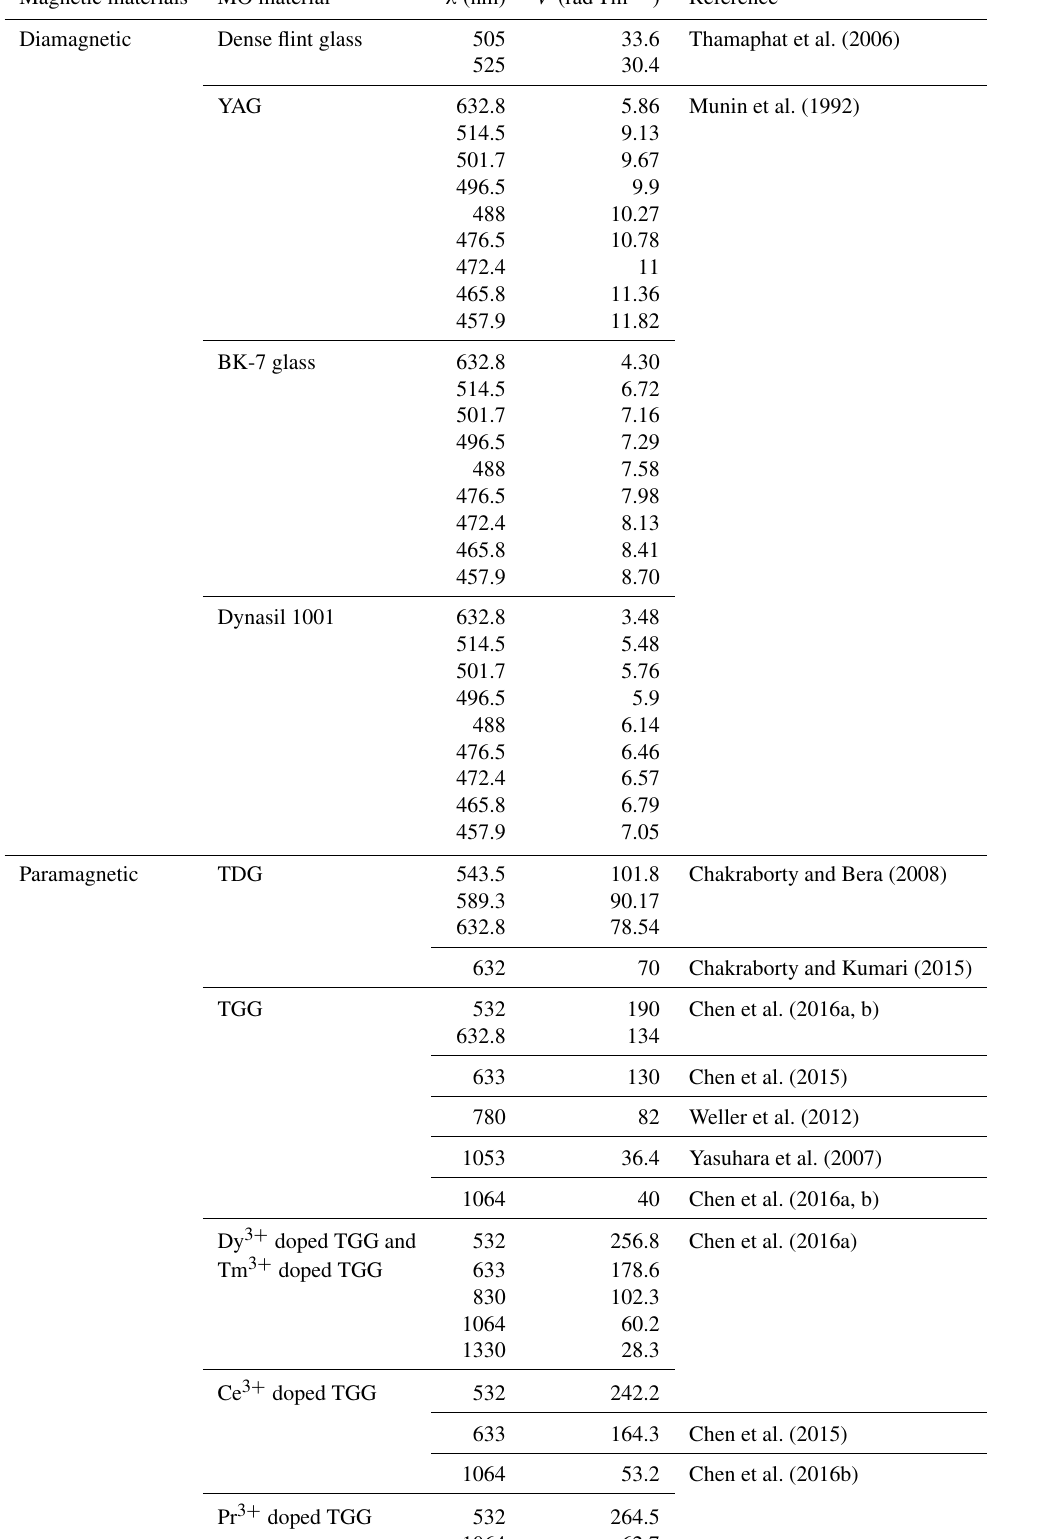
Table 1. Verdet constants of various MO